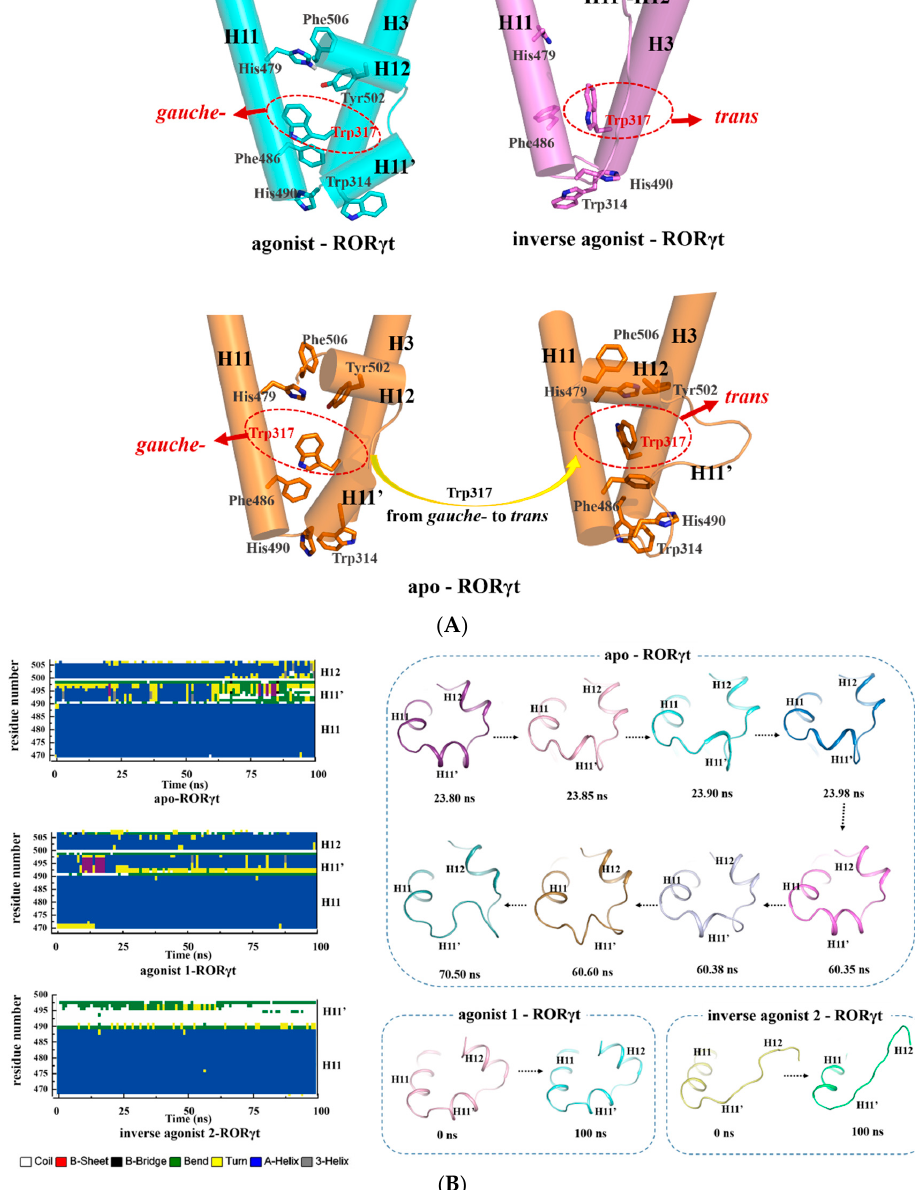
Figure 6. ( A ) Conformational states of Trp317 in the apo, agonist-bound, and inverse agonist-bound ROR γ t system. Apo-ROR γ t shown in orange, agonist 1 -ROR γ t shown in blue and inverse agonist 2 -ROR γ t shown in magenta; ( B ) the monitored secondary structures and representative conformations of H11, H11 (cid:48) , and H12 as observed from the apo, agonist-bound, and inverse agonist-bound ROR γ t system. The color code at the bottom represents the DSSP classification of each secondary structure element. Conformations of H11, H11 (cid:48) , and H12 in apo-ROR γ t at 23.80 ns, 23.85 ns, 23.90 ns, 23.98 ns, 60,35 ns, 60.38 ns, 60.60 ns and 70.50 ns were shown in deep purple, wheat, cyan, blue, magentas, gray, orange and green respectively. Conformations of H11, H11 (cid:48) , and H12 in agonist 1 -ROR γ t at 0 ns and 100 ns were shown in pink and lime. Conformations of H11, H11 (cid:48) , and H12 in inverse agonist 2 -ROR γ t at 0 ns and 100 ns were shown in yellow, green and